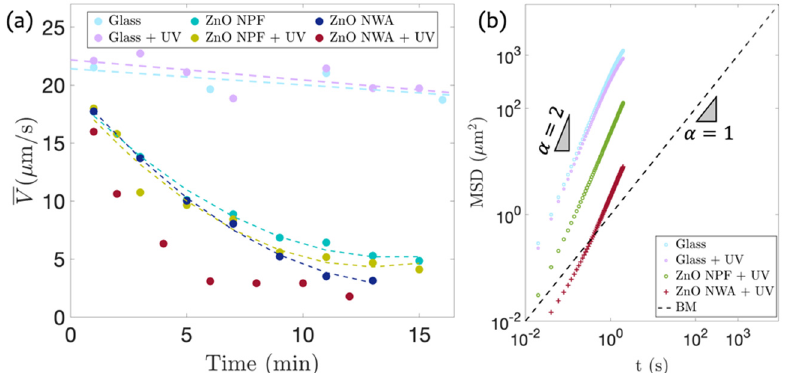
Figure 5. Mean speed and ballistic diffusion of bacterial spreading on various surfaces with and without UV irradiation. ( a ) Replot of bacterial motility as a function of time on ZnO NWA, ZnO NPF, and bared glass substrates, respectively. ( b ) Mean squared displacement depends on the lag time, showing the ballistic and super diffusion processes.